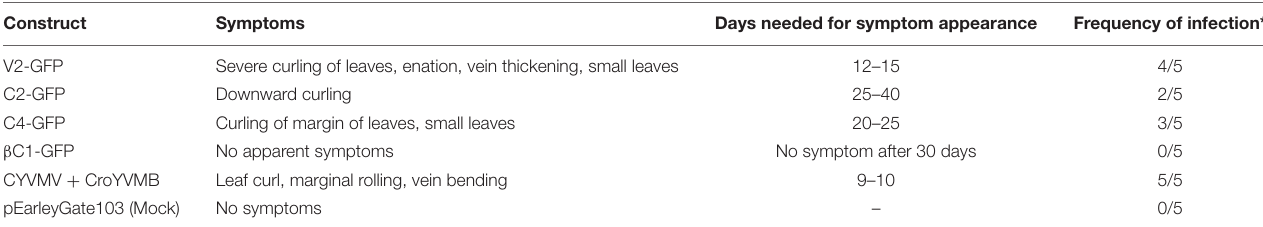
TABLE 1 | Pathogenicity determination of croton yellow vein mosaic virus (CYVMV)-encoded V2, C2, C4, and betasatellite-encoded C1 protein ( β C1) through their transient overexpression in N. benthamiana . Construct